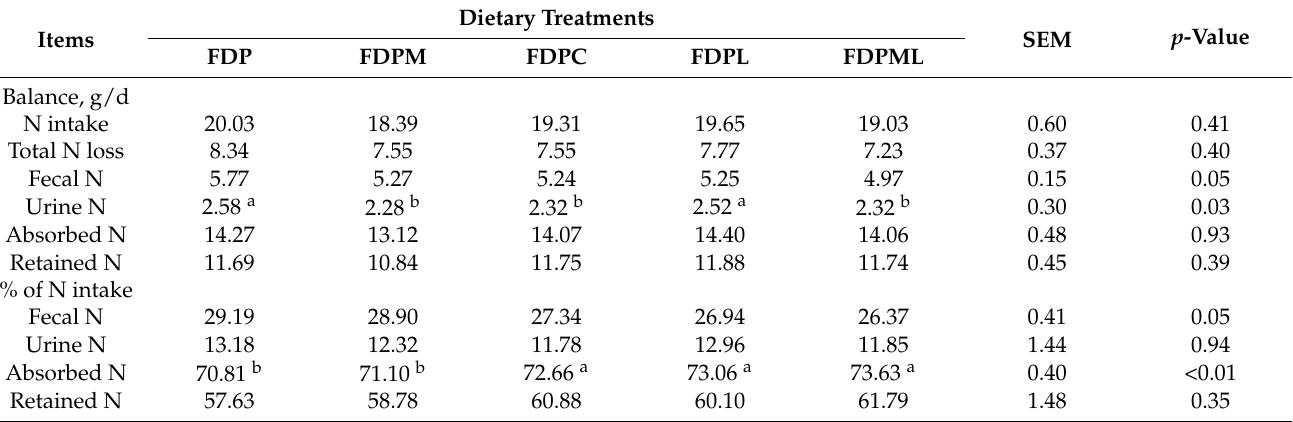
Table 7. Effects of untreated and treated discarded durian peel in TMR on nitrogen utilization in growing